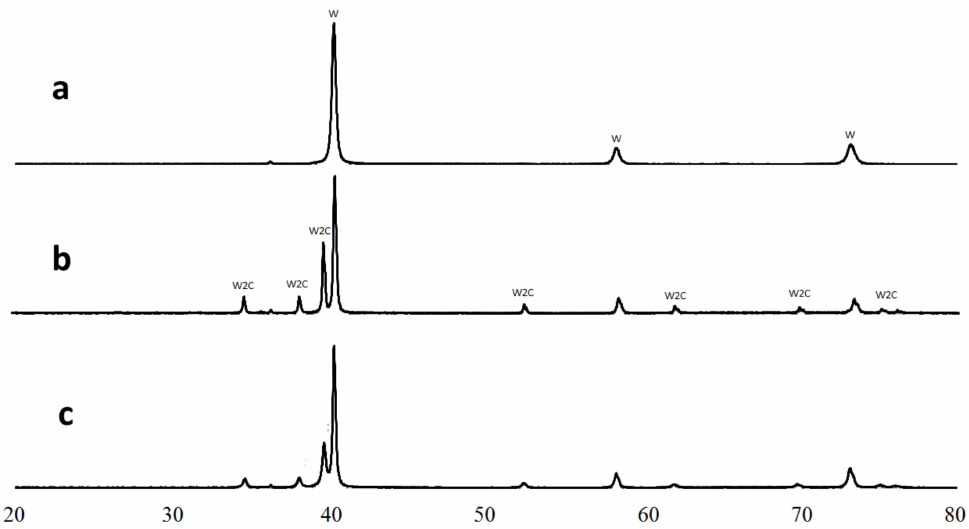
Figure 5. X-ray diffractometry of W + 1.3%C composition: milled powder ( a ), sample 5 sintered at 900 ◦ C ( b ), and sample 4 sintered at 1300 ◦ C ( c